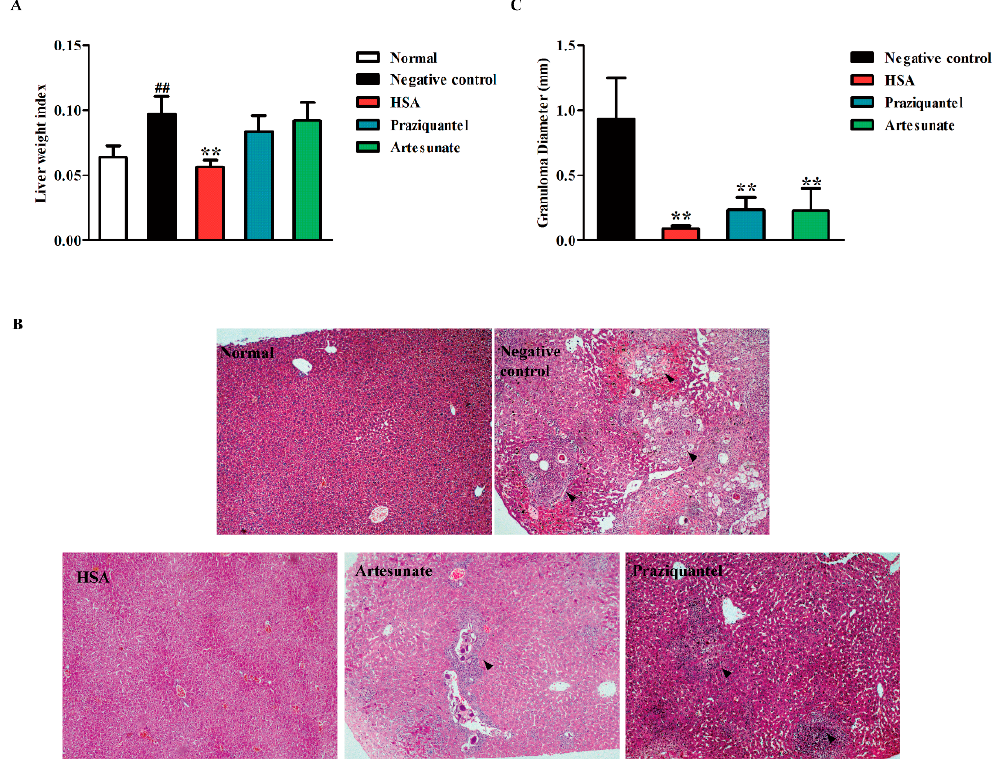
Figure 3. Reduction of hepatic granulomatous inflammation by HSA treated 1–5 days S. japonicum post-infected mice. Mice were treated with administration of 8 mg·kg − 1 HSA, 300 mg·kg − 1 praziquantel (positive control) and 300 mg·kg − 1 artesunate (positive control) as antischistosomal treatments for 1-day-old juvenile S. japonicum infection. The effect of HSA on hepatic granulomatous inflammation of infected mice was tested. ( A ) Liver weight index (liver weight/body weight). Each bar represents the mean ± SD. ## p < 0.01 vs. Normal, t -test; ** p < 0.01 vs. Negative control, t -test; ( B ) Representative hepatic granulomas of untreated and drug-treated mice. Photographs were taken at 100× (H&E). Black arrows represent the area of granuloma; ( C ) Quantification of egg-induced liver pathology by measurement of mean granuloma diameter. Each bar represents the mean ± SD; ** p < 0.01 vs. Negative control, t -test. Table 4. Ova load in S. japonicum infected mice received HSA, praziquantel or artesunate treatment.